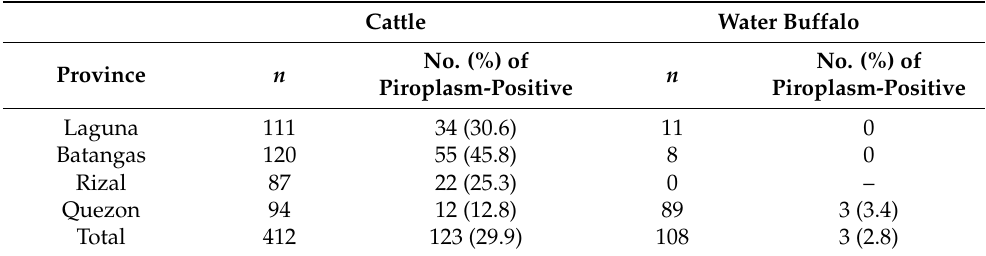
Table 1. Number and percent (%) of blood samples from cattle and water buffalo from selected provinces in Luzon, Philippines, that tested positive for piroplasms ( Babesia/Theileria ), based on nested PCR. n = number of tested samples. Cattle Water Buffalo Province